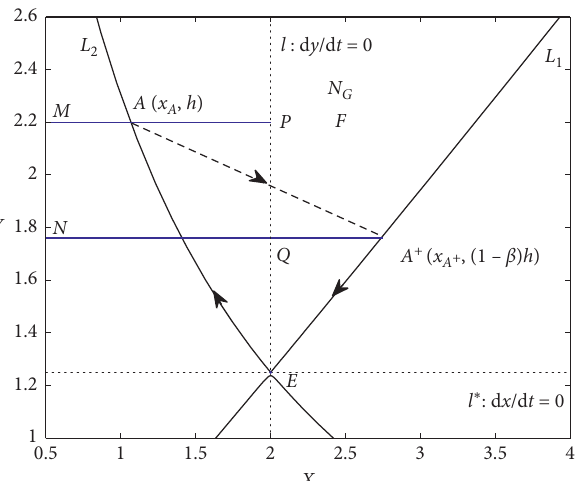
Figure 3: Homoclinic cycle of model (2) with parameter values: a � 5 ,c � 4 ,d � 6 , e � 3 ,h � 2 . 2 , β � 0 . 2, and α � 1.